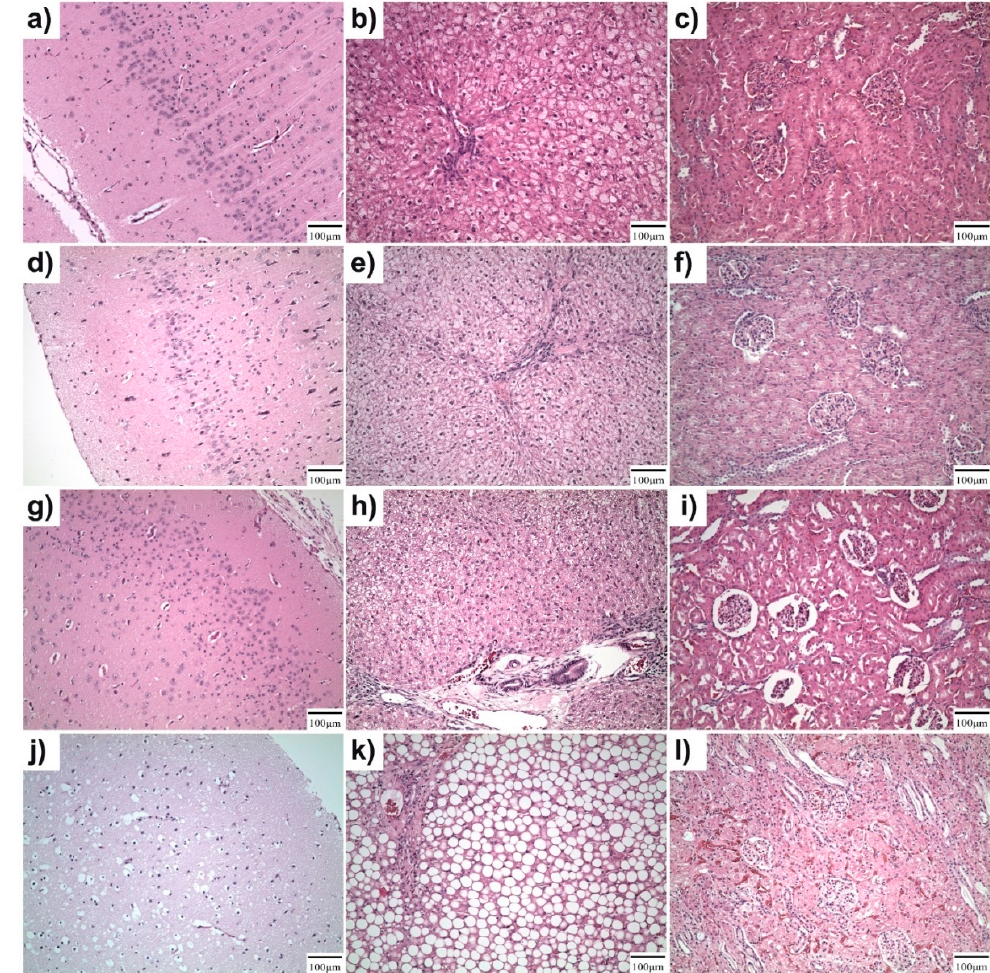
Figure 11. Histological analysis of vital organs, brain (left column), liver (middle column), and kidney (right column) ( a – c ) 120 days after experimental screw implantation, ( d – f ), 240 days after experimental screw implantation, ( g – i ) 360 days after experimental screw implantation, ( j – l ) 360 days after Ti ‐ based screw implantation. No detectable changes between experimental screw groups and Ti ‐ based screws used as a control. ( k ) Massive hepatic steatosis visible in the liver occurred 360 days after Ti ‐ based screw